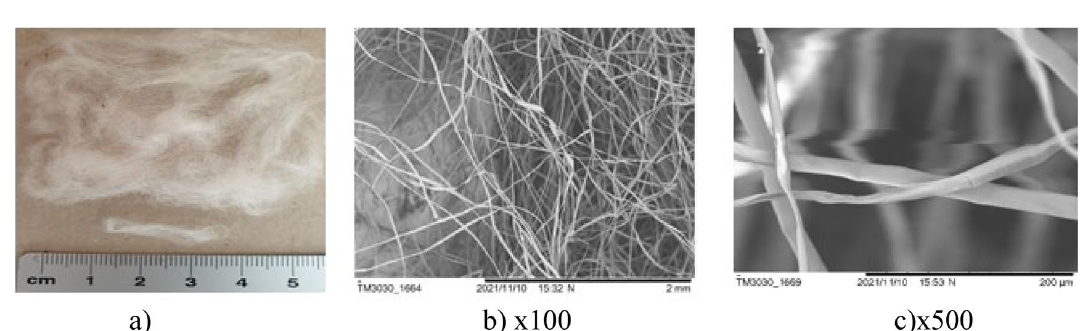
Figure 8. SEM of sisal fibre [Fot.M.Kurpińska].